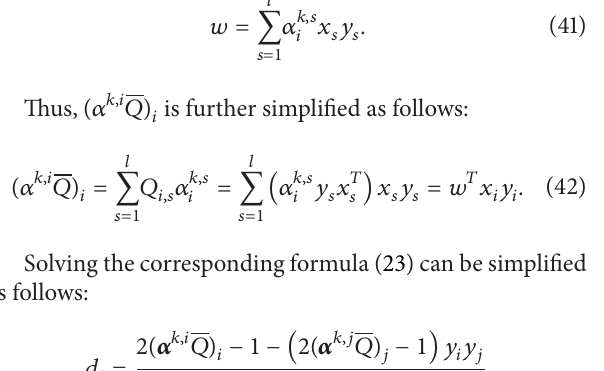
Algorithm 3 . Cost-sensitive support vector machine